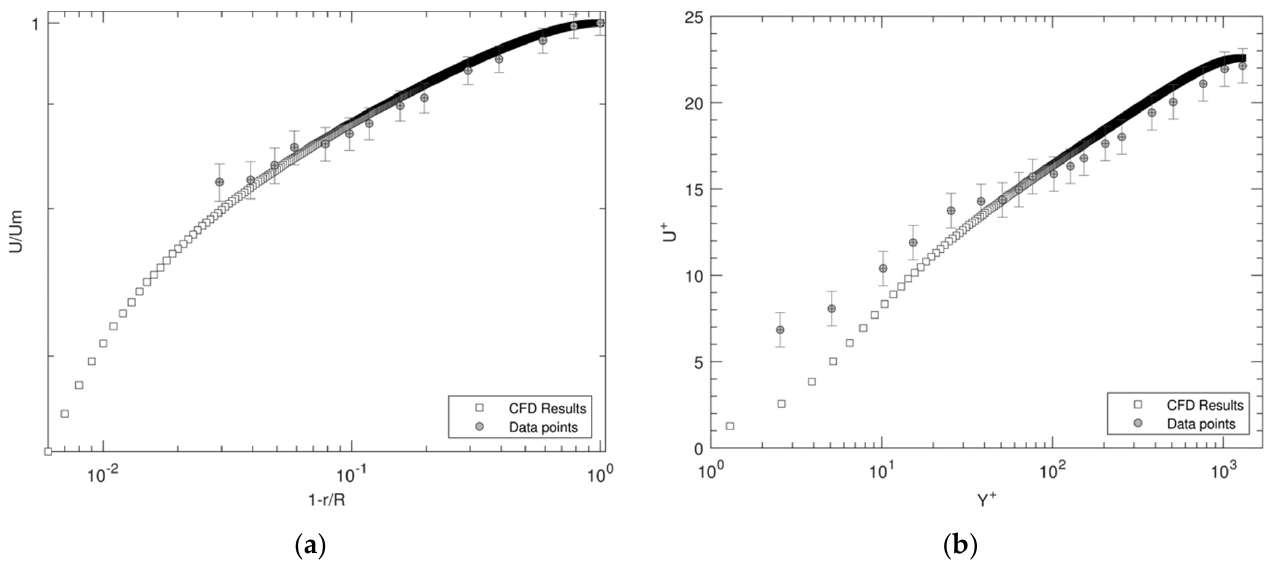
Figure 8. Velocity profiles comparison between experimental and CFD results: ( a ) Normalized velocity versus the dimensionless distance from the pipe wall on logarithmic axes; ( b ) Dimensionless velocity U+ versus the dimensionless distance from the pipe wall Y+.